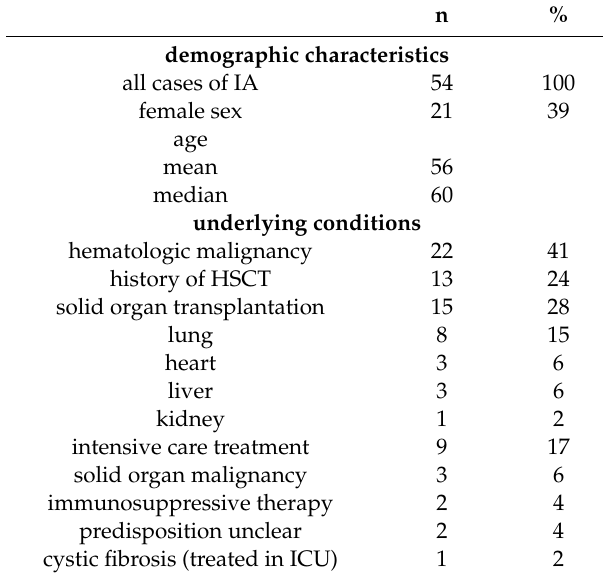
Table 3. Demographic characteristics and underlying conditions of IA